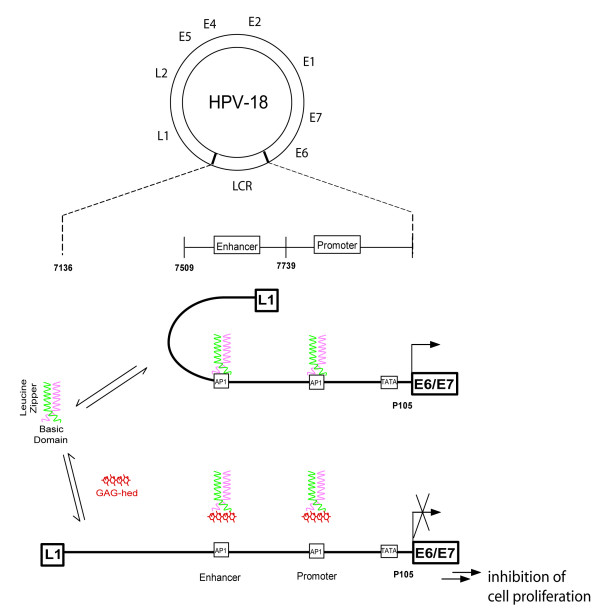
Proposed model for GAG-hed modulation of AP1 transcription factor in HPV18 LCR. Fos-Jun/AP1 transcription factor complex is bound off in the presence of GAG-hed. GAG-hed-AP1 complex is rendered stable and unable of binding to DNA. Model in based in data reported in previous work [30,69] and particularly adapted to HPV18-LCR. Circular HPV18 genome showing the early and late open reading frames (ORF). The LCR has been expanded to show clearly the promoter and enhancer regions in front of E6 and E7 genes. The AP1 binding sites located in the promoter and the enhancer are indicated. Apart from the TATA sequence, the other known binding sites for transcription factors in the LCR of HPV18 have not been indicated.